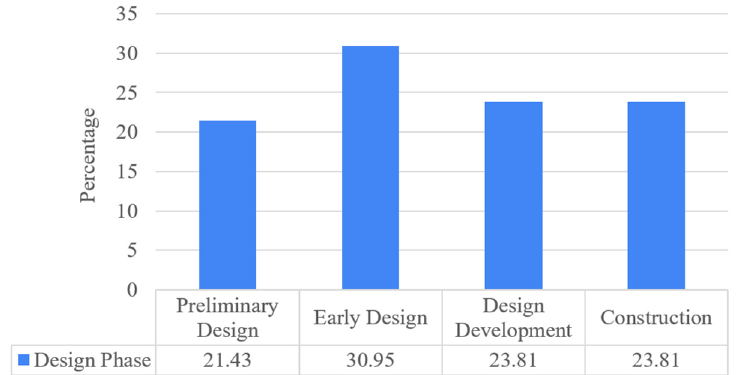
Figure 3. The percentage of contractor’s engagement during the project phases according to respondents’ feedback.